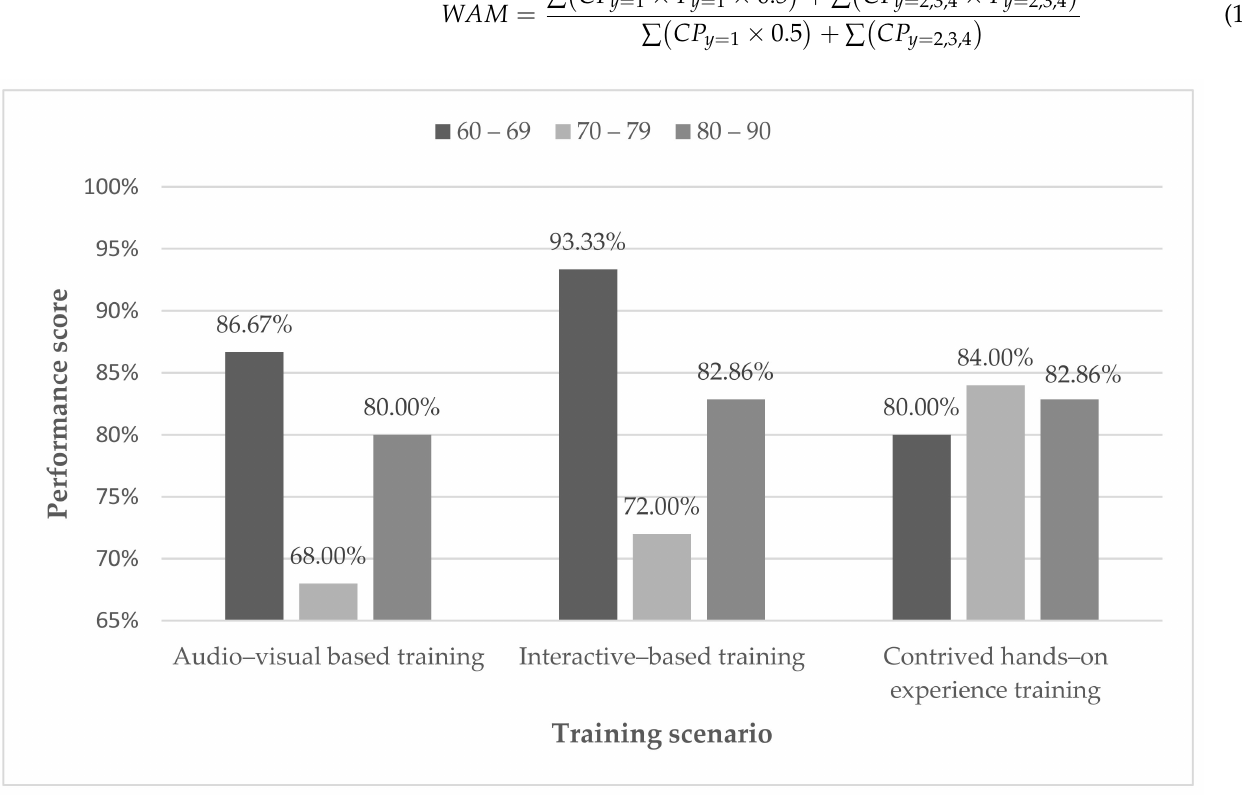
Figure 7. Mean performance score of different WAM groups of participants when subjected to different VR training